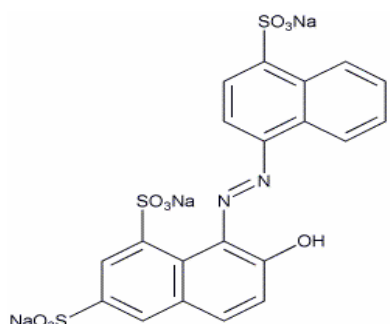
Figure 3. Structure of the azo dye Acid Red